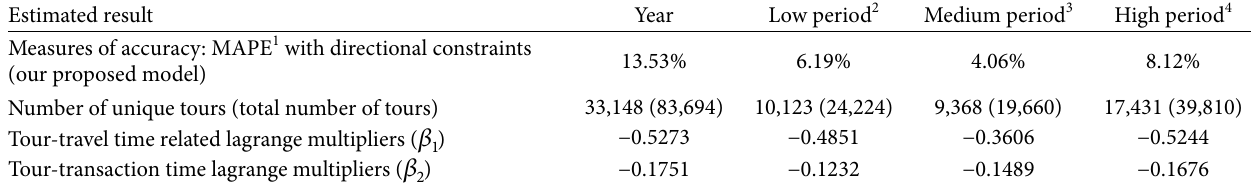
1: Estimated results of coastal truck tour-based entropy maximization